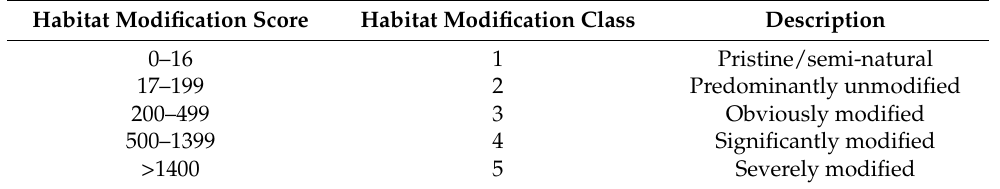
Table 1. Description of the five Habitat Modification